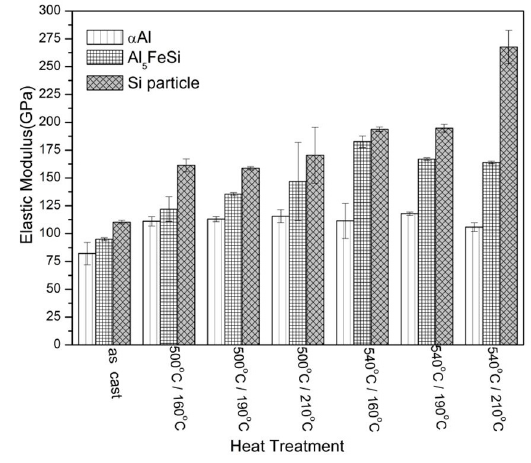
Figure 11. Hardness behavior for each relevant phase of the Al-Si- Cu alloy obtained from nanoindentation tests.